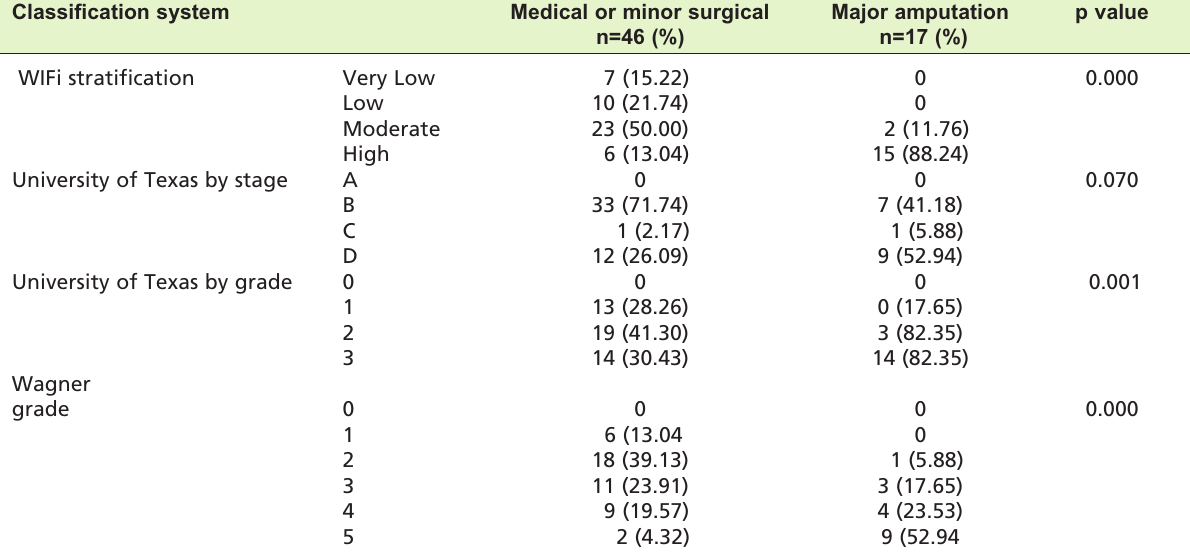
Association of WIFi, University of Texas, and Wagner classifications with Table II: